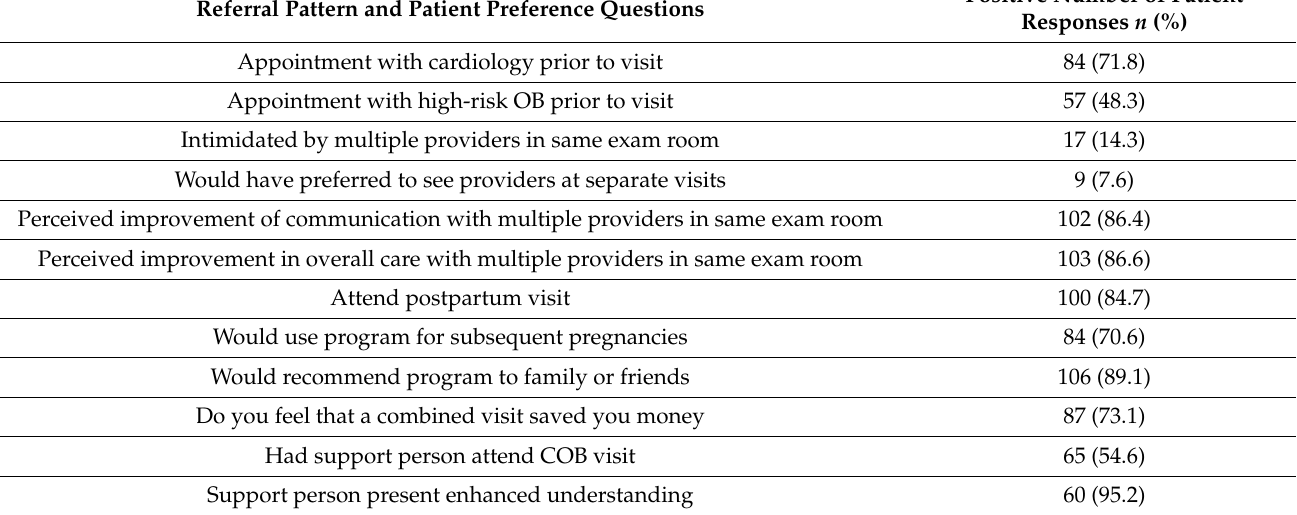
Table 3. Care patterns and preferences of women within the combined Cardio-Obstetrics clinic of Saint Luke’s Hospital of Kansas City.